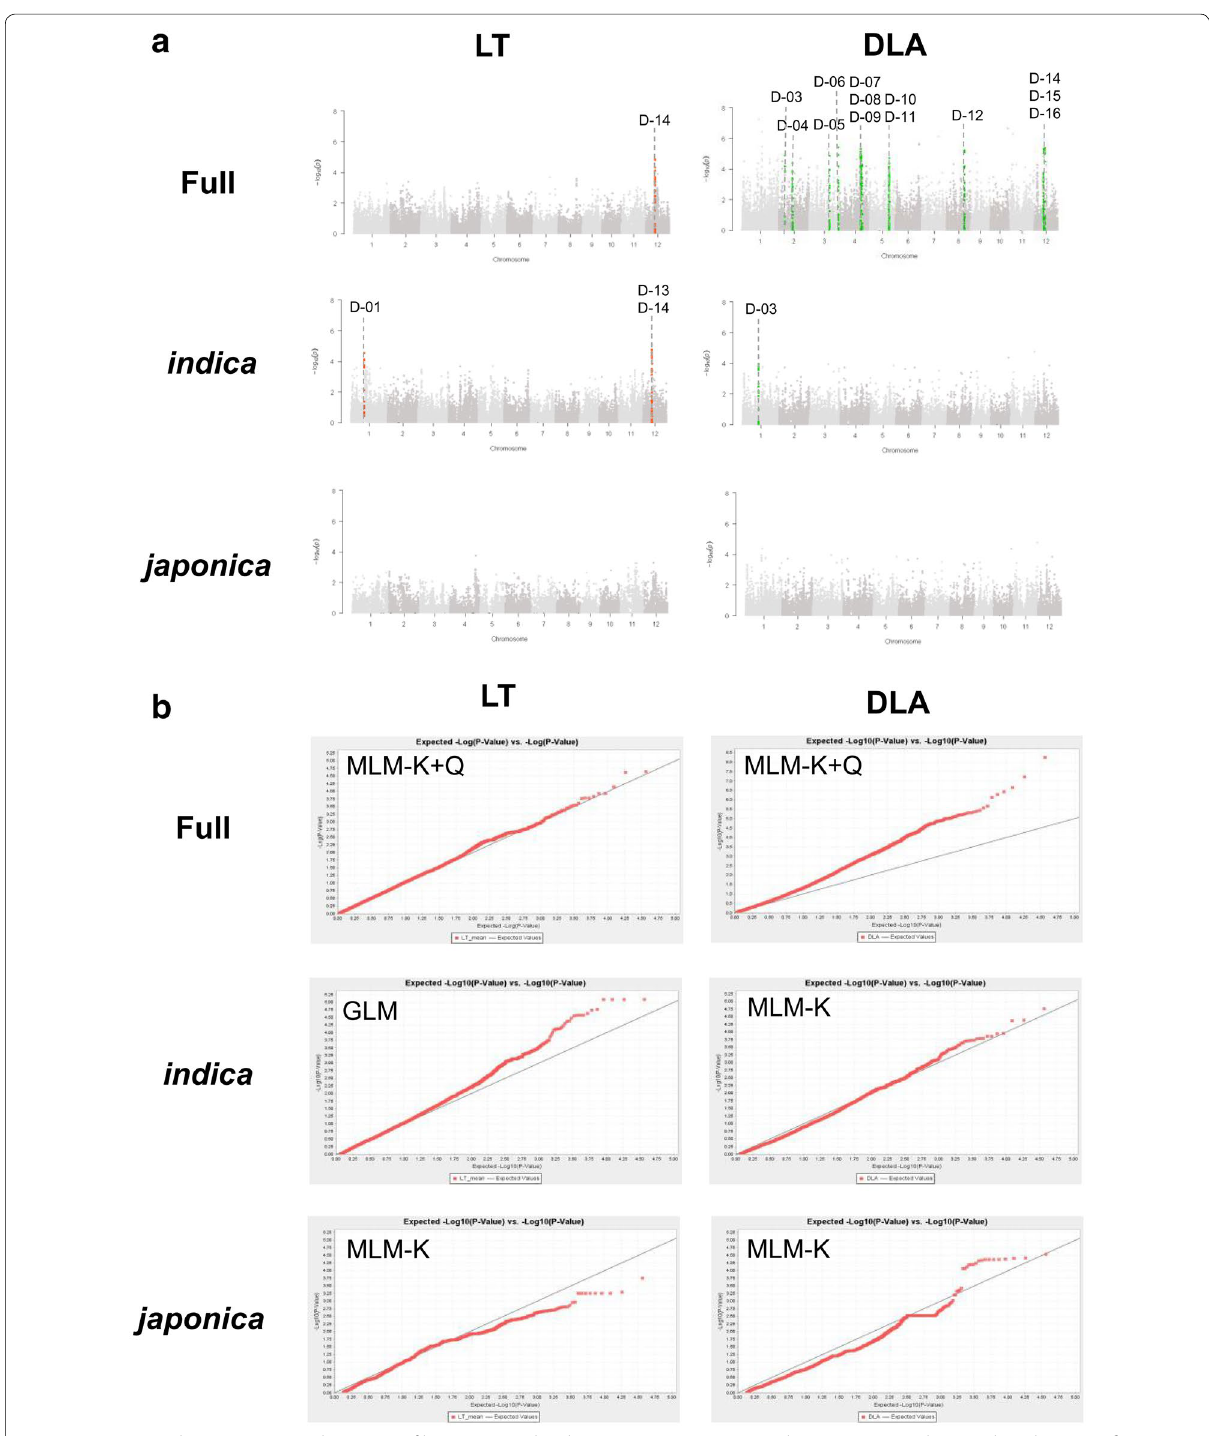
Fig. 2 Genome‑wide association study (GWAS) of loci associated with resistance to M. oryzae isolate D41‑2. a Manhattan plots show significant genomic regions (D‑01 to D‑16) identified by using lesion type (LT) and diseased leaf area (DLA) dataset. X axis: rice chromosomes; Y axis: Log 10 ( P ). b Quantile–quantile (Q–Q) plots show the fitness of the selected models used for different traits in the full population or subgroups. X − axis: expected Log 10 ( P ); Y axis: observed Log 10 ( P − −